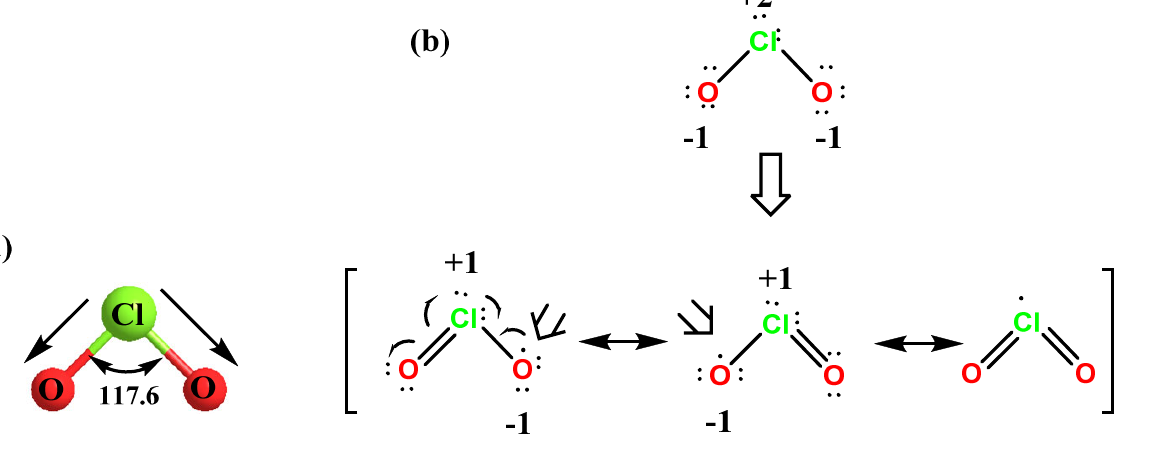
Figure 2. ( a ) The molecular structure of ClO 2 . ( b ) The Lewis structure of ClO 2 .